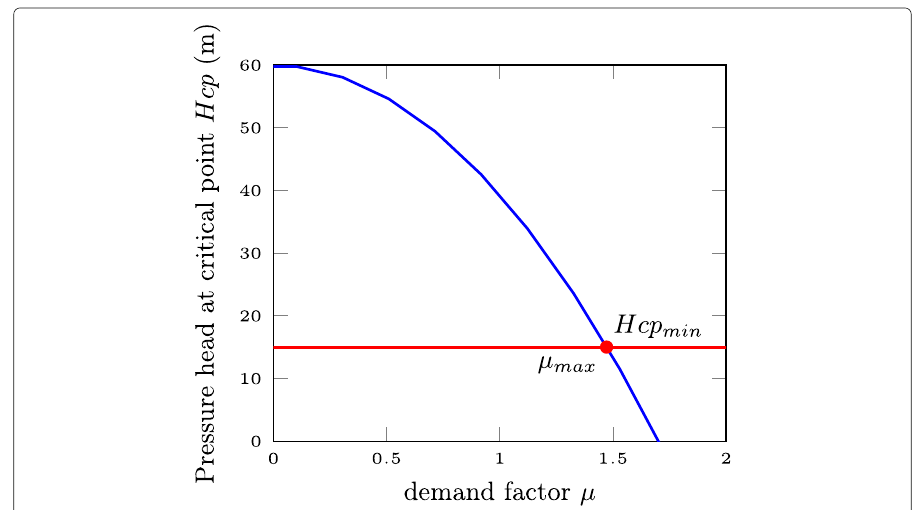
Fig. 1 Definition of reserve capacity. As the demand factor μ increases, the pressure head at the critical node decreases, until it reaches the minimum allowed pressure. The value of μ when the pressure head at